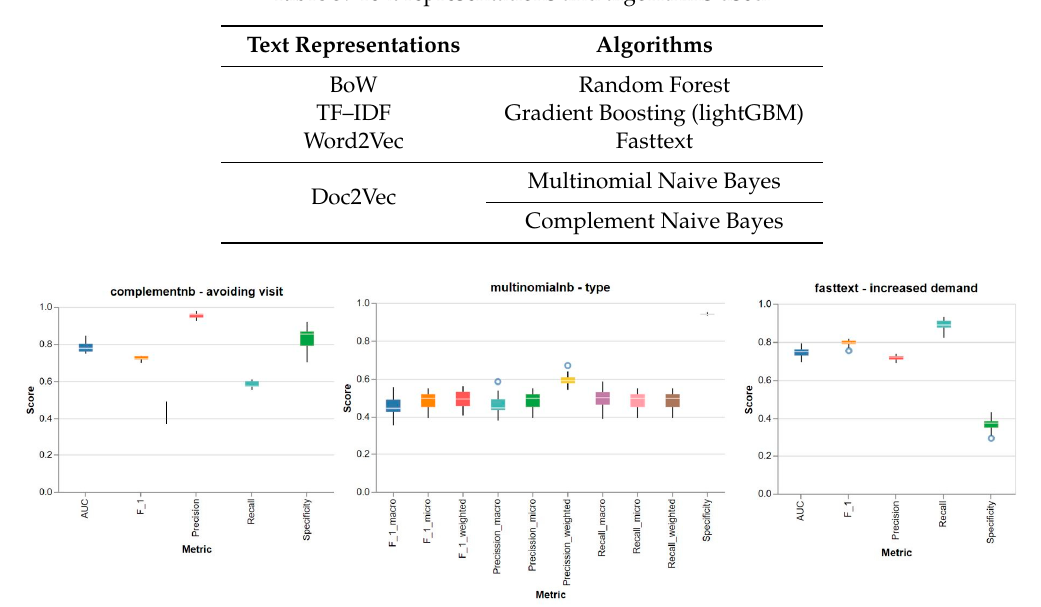
Figure 1. Performance metrics of algorithms.